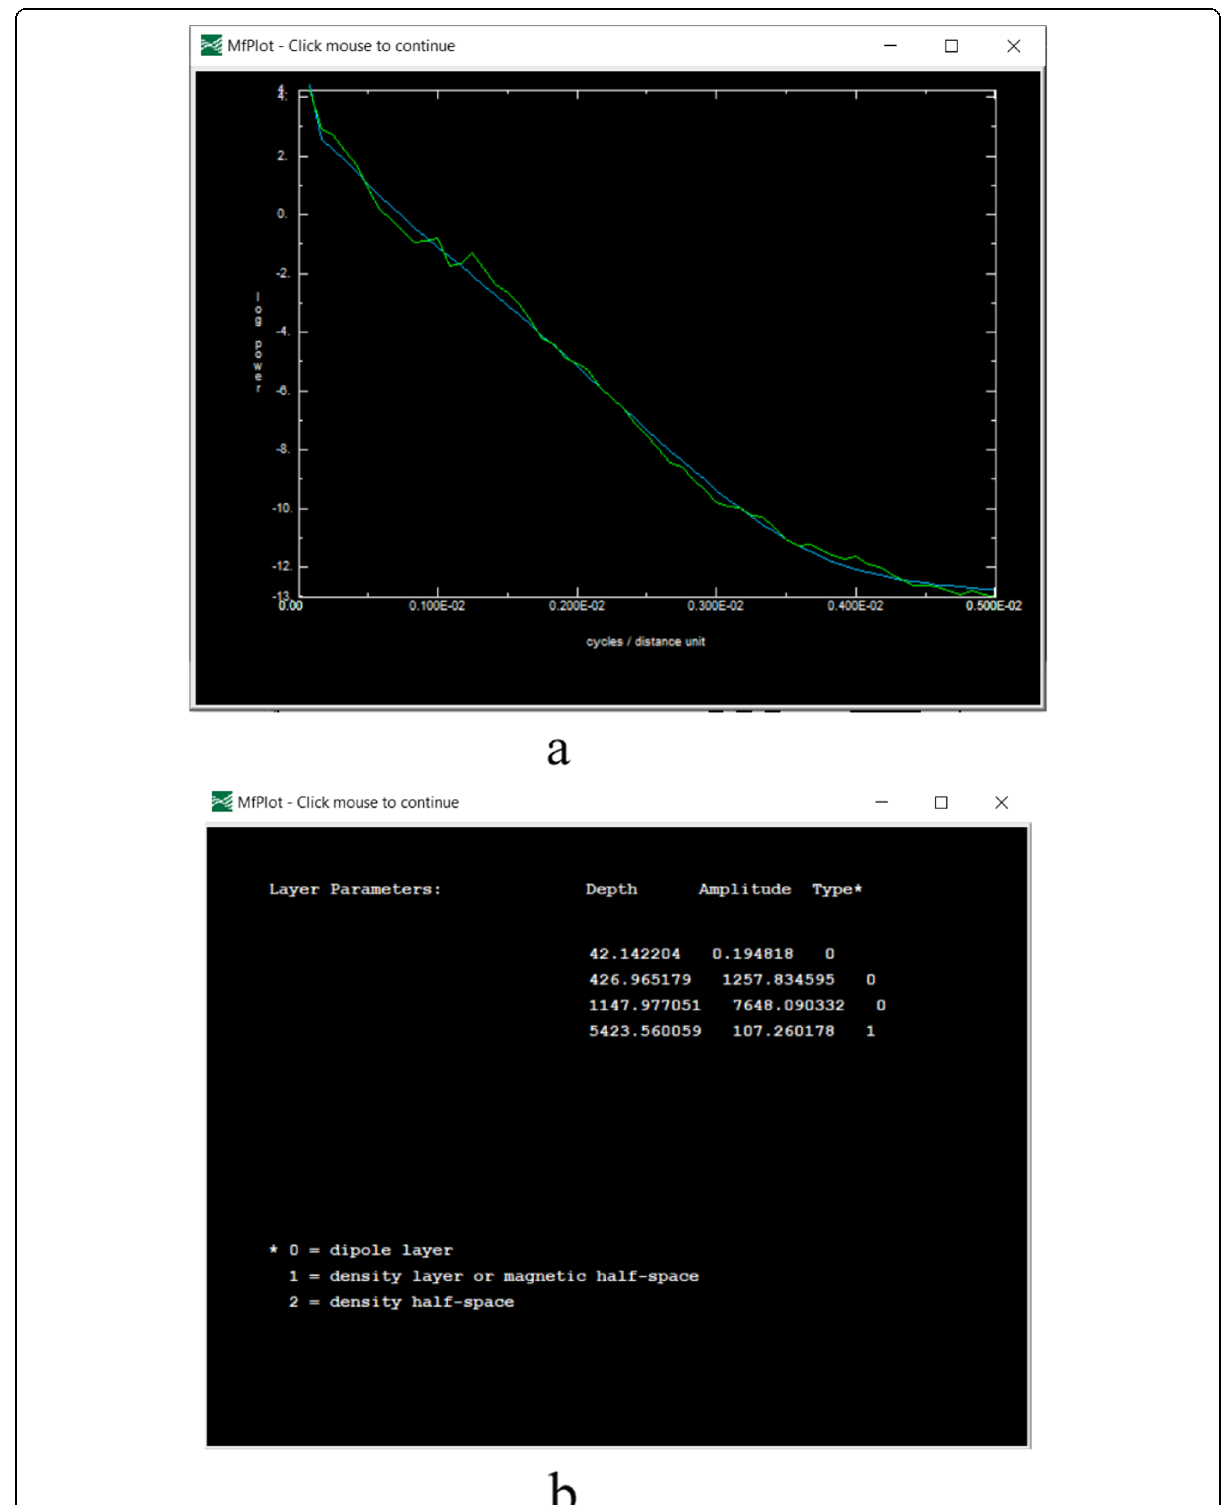
Fig. 19 a Power spectra of the Pankshin Area Magnetic data (green) and of a model (blue) consisting of four equivalent magnetic layers designed using the matched filtering (depth slicing) after Phillips (2001). b Magnetic layer parameter generated by the application of the matched